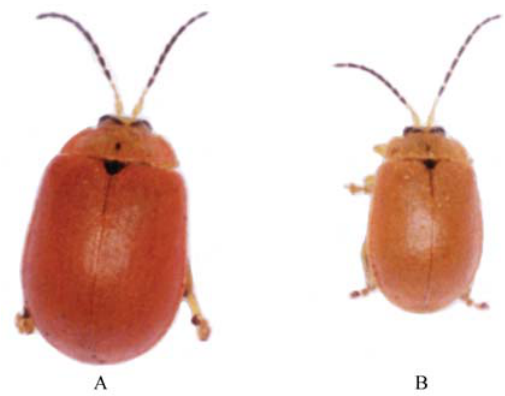
Figure 1 - Specimens of Paranaita opima . A. Female. B. Male. Magnifi- cation =